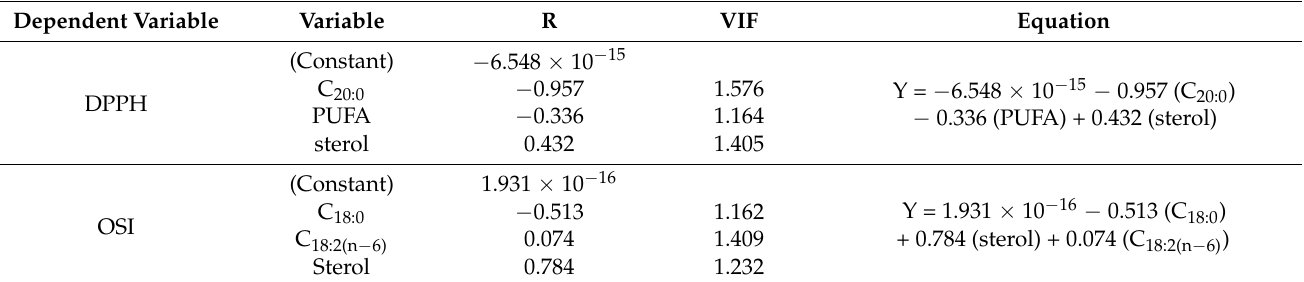
Table 5. Prediction of the relationship between antioxidant capacity and minor components by multiple linear regression